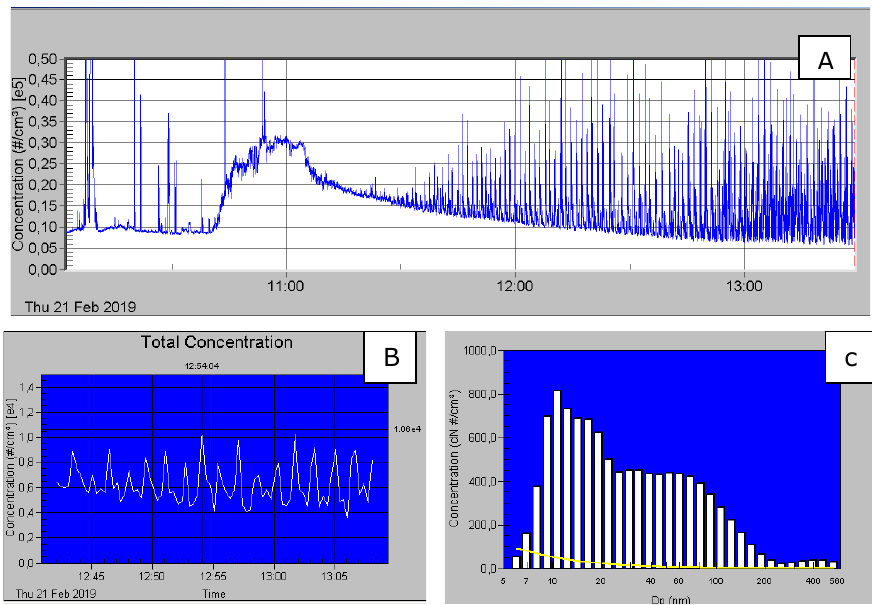
Figure 7 . Nanoparticles during ABS printing (CPC concentration)